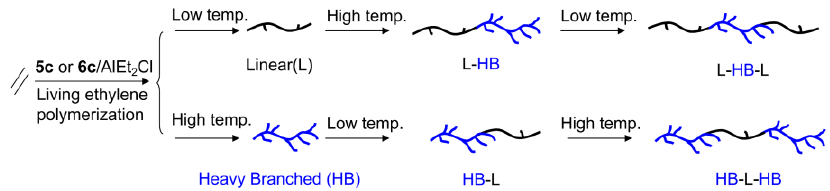
Scheme 5. Synthesis of block PE featuring different branched segments by sequential tuning of liv- ing polymerization temperature.